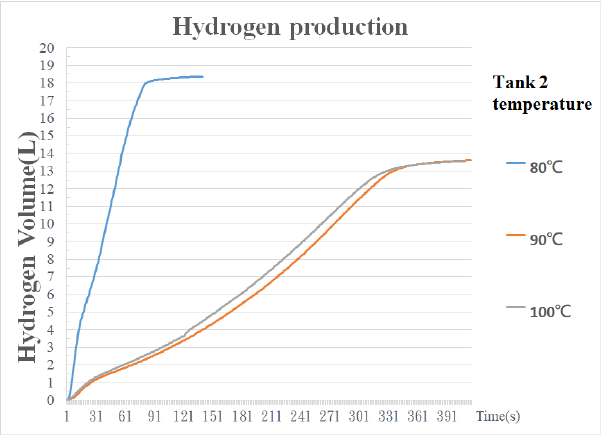
Figure 7. Comparison of hydrogen production rates at different catalyst bed temperatures for the secondary hydrogen production tank.